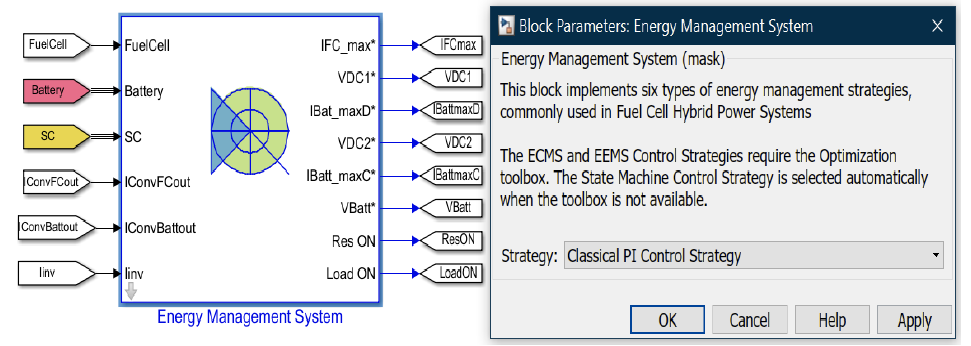
Figure A1. EMS—classical PI control strategy setup.